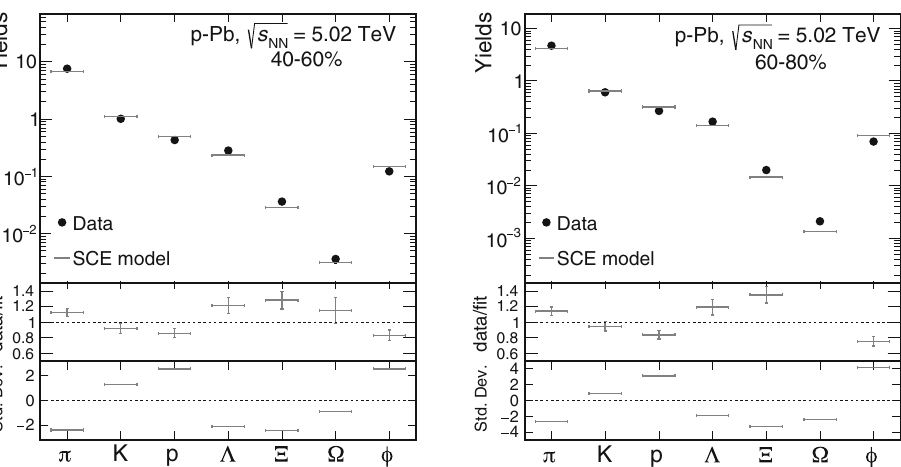
logarithmic scale easily hides the quality of the fits, we also show in the middle of the figures the ratio of the experimental data to the thermal model fit. In the lowest part of the figures we show the standard deviation for each particle, calculated in the standard way as Std.